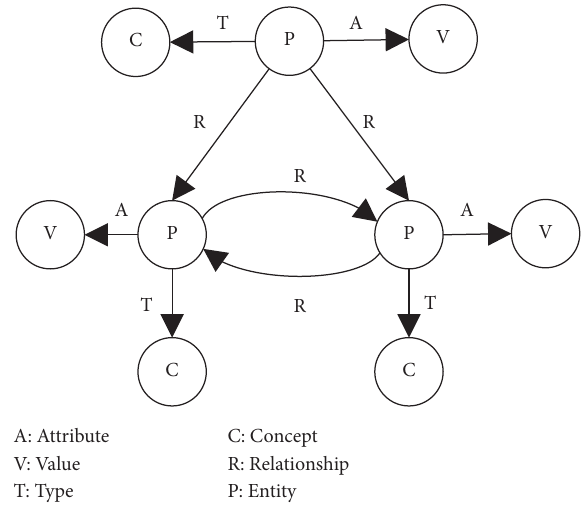
Figure 1: Knowledge graph